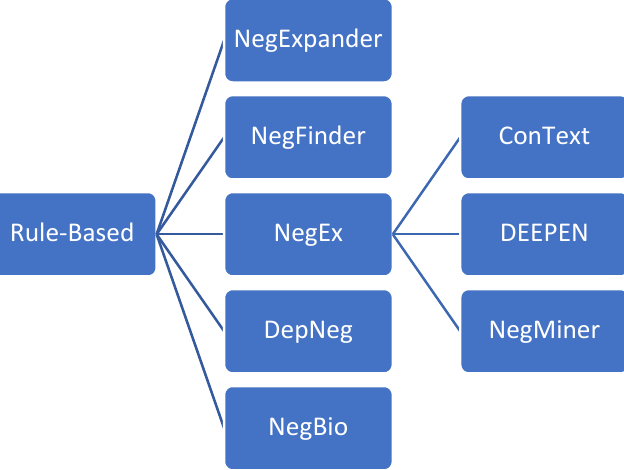
Figure 1. Taxonomy of Rule-based Algorithms.